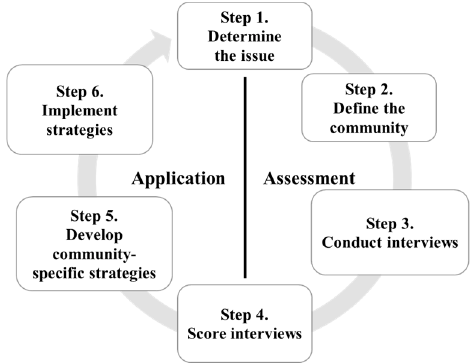
Figure 1. Step-by step process of community readiness. The first phase of community readiness (assessment) includes steps 1–4. Step 4 (scoring the interviews) determines the readiness level (1–9) of a community. The second phase (application) includes steps 5–6 and involves the community to develop and implement strategies based on the stage of